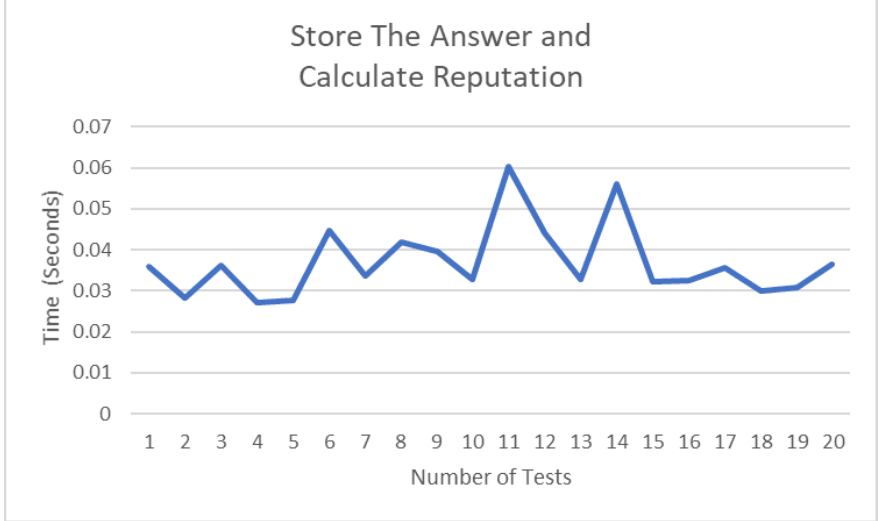
Figure 23. Time taken to calculate and store the reputation score of nodes.